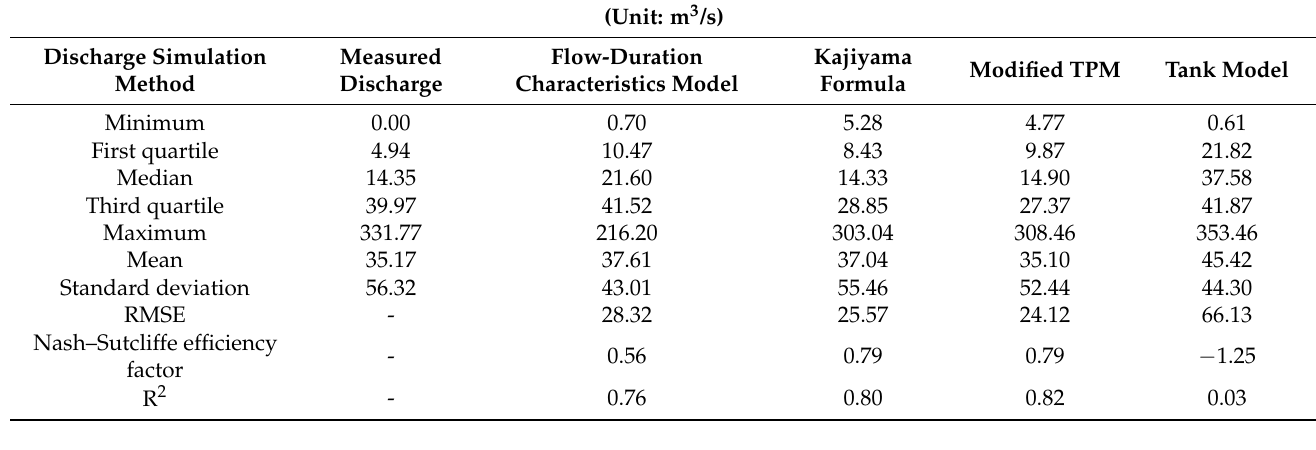
Table 6. Comparison of the distributions and statistics of the simulated and measured monthly average discharge for the Deoksong SHP plant. (Unit: (cid:1813) (cid:2780) /(cid:1819) )